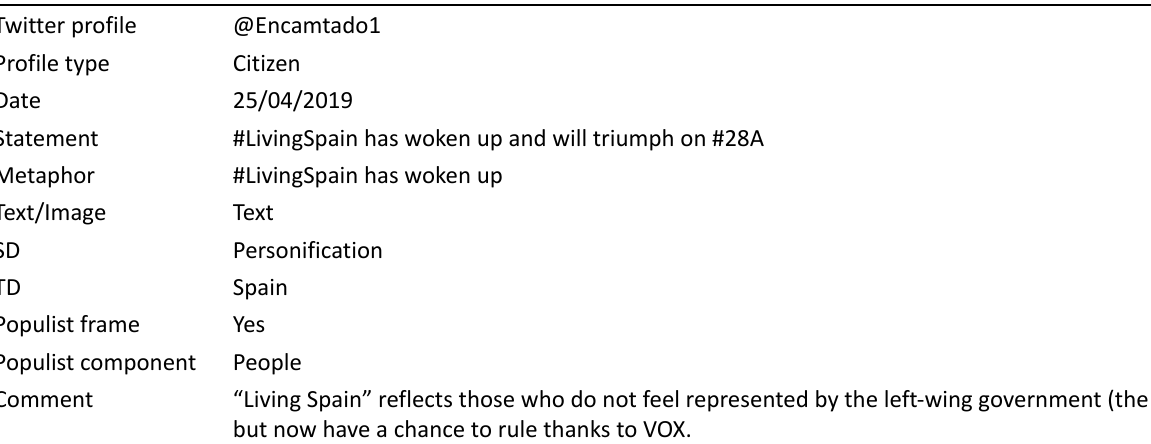
Table 1. Coding variables with #LivingSpain as an example. Twitter